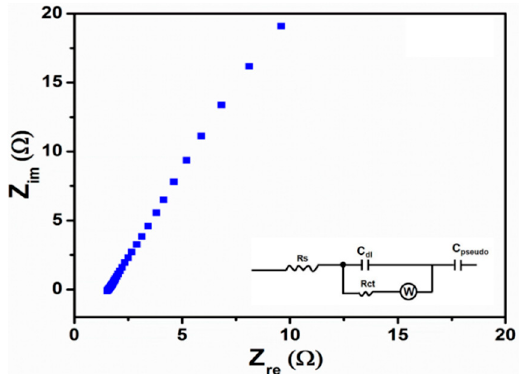
Figure 8. The EIS plot of the synthesized mesoporous Mn 2 O 3 electrode at the Z im versus the Z re mode. The inset shows its corresponding equivalent circuit.